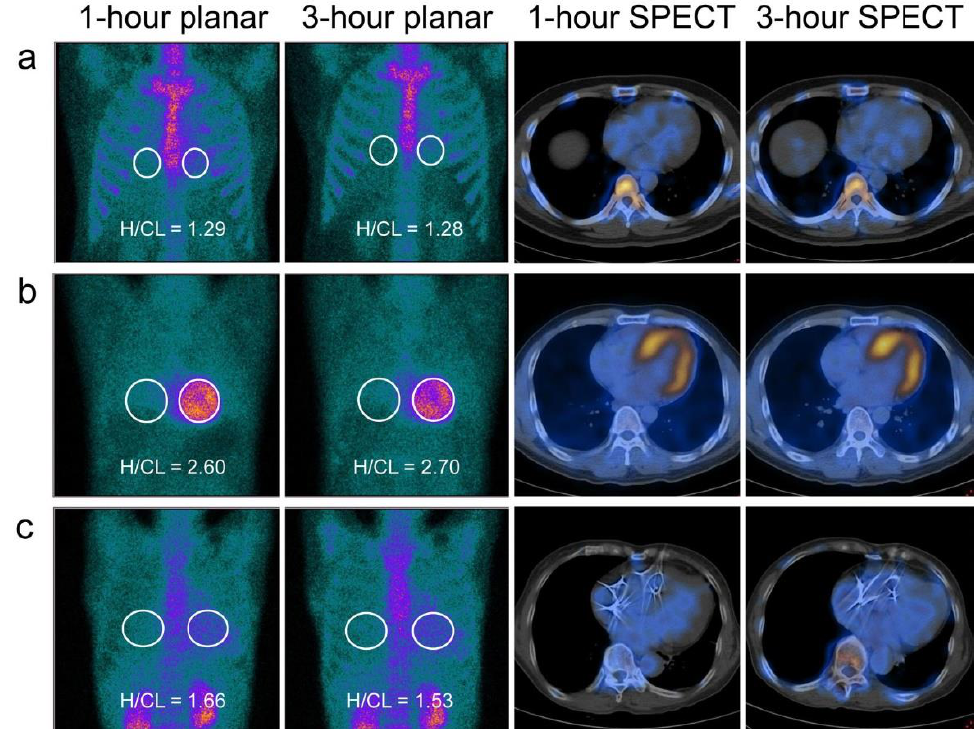
Figure 1. 99m Tc-PYP planar and SPECT/CT scans obtained at 1 and 3 h in typical cases. White ellipse /circle of region of interest (ROI) was drawn over the precordium on anterior planar images, and mirrored to the contralateral chest for correcting the uptake in ribs and lung background. ( a ) The patient had negative planar studies at both 1 and 3 h based upon semi-quantitative visual grading scale relative to ribs (VGSr), visual grading scale relative to the upper segment of the sternum (VGSs), and heart-to-contralateral (H/CL) ratio approaches, respectively. 1- or 3-h SPECT/CT imaging allows identification of radiotracer activity in the left ventricular cavity other than the myocardium. ( b ) Despite the lack of heart failure symptoms, this patient had positive planar studies at both 1